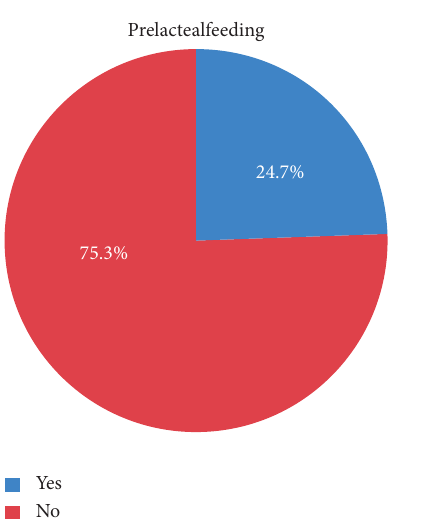
Figure 1: Magnitude of prelacteal feeding among mothers of children aged less than 12 months in the rural eastern zone, Tigray, Ethiopia,